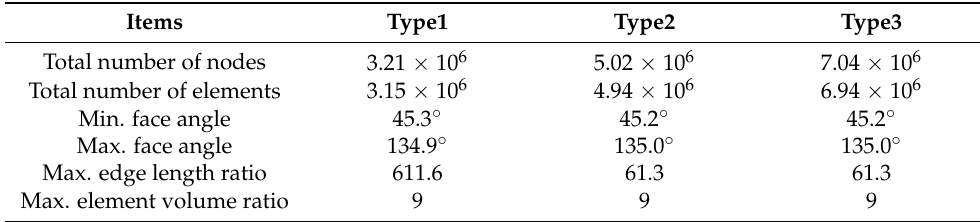
Table 5. Grid information.